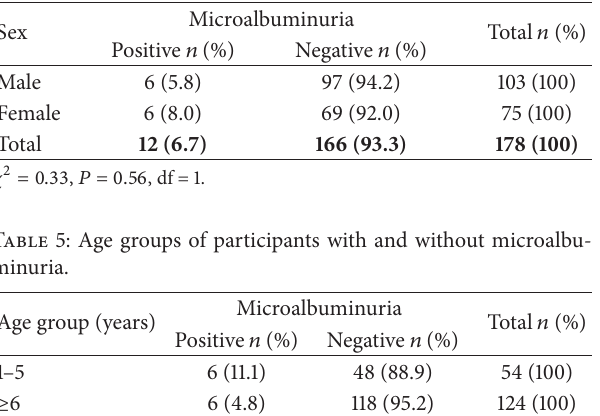
Table 4: Sex distribution of study participants with and without microalbuminuria.